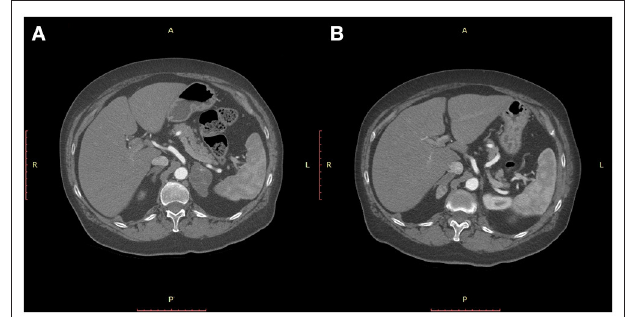
FIGURE 2 | Pathological examination of adrenal metastatic disease. Histological examination revealed metastasis from invasive breast carcinoma, arranged in solid nests or ductal structures (black arrowheads) in adrenal gland (black asterisks) (hematoxylin and eosin, original magnification 4 × ).